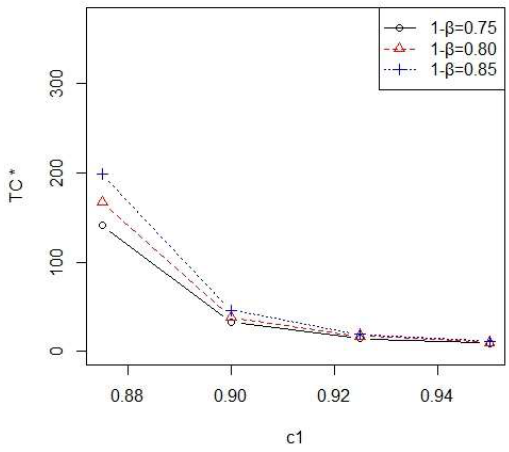
Figure 3. Minimum total cost curve for  = 0.01, 0.05, 0.1 at β = 0.25 and p = 0.05.